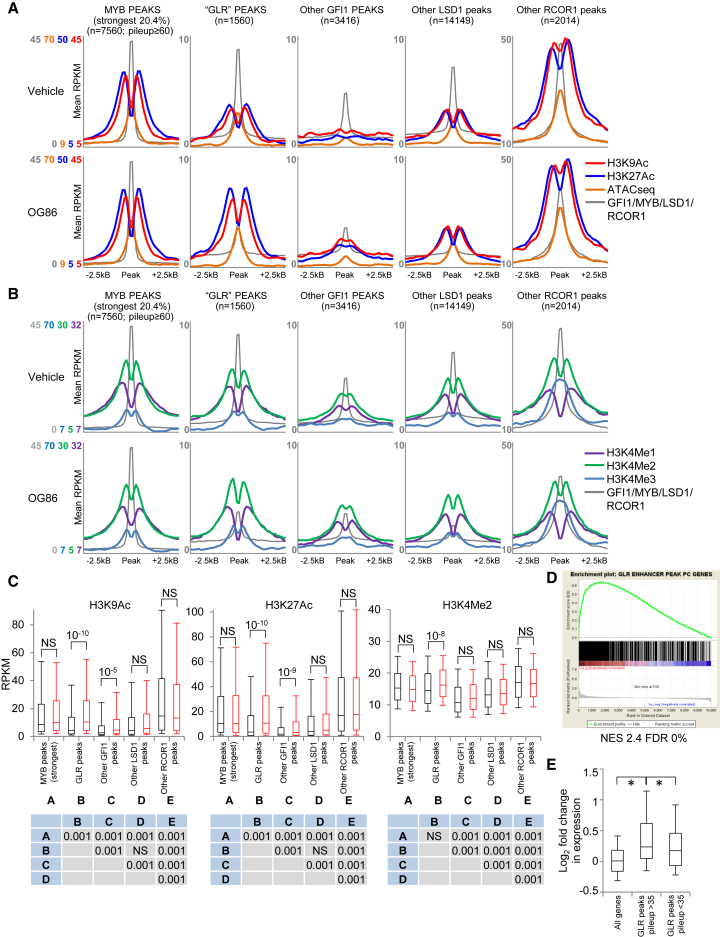
Chromatin Profiles Surrounding Transcription Factor Binding SitesTHP1 AML cells were treated with 250 nM OG86 or DMSO vehicle for 24 hr.(A and B) Graphs indicate (A) mean ChIP-seq signal for H3K9Ac and H3K27Ac and ATAC-seq signal or (B) mean ChIP-seq signal for H3K4Me1, H3K4Me2, and H2K4Me3 (reads per kilobase per million mapped reads; RPKM) surrounding the indicated MYB, GFI1/LSD1/RCOR1 coincident peaks, “GLR” peaks, or other GFI1, other LSD1, or other RCOR1 peaks at intronic and intergenic binding sites (i.e., putative enhancers) in the indicated conditions.(C) Box-and-whisker plots show median, 25th, and 75th percentile values (box) and 10th and 90th percentile values (whiskers) for normalized ChIP signal for H3K9Ac, H3K27Ac, and H3K4Me2 surrounding (± 1 kb) the indicated peak categories. Black boxes indicate DMSO vehicle; red boxes indicate OG86. The p values (t test) are shown for the indicated comparisons. NS, not significant. Tables beneath box-and-whisker plots show p values for comparisons of signal at the indicated peak categories (labeled A–E) in the DMSO vehicle condition, as determined by one-way ANOVA and Tukey’s honest significant difference post hoc test.(D) GSEA plot. NES, normalized enrichment score; FDR, false discovery rate.(E) Box-and-whisker plots show median, 25th, and 75th percentile values (box), and 10th and 90th percentile values (whiskers) for log2 fold change in expression of all expressed protein coding genes or those located next to stronger (pileup ≥ 35) or weaker (pileup < 35) “GLR” peaks. ∗p < 0.001, as determined by one-way ANOVA and Tukey’s honest significant difference post hoc test.See also Figure S5.